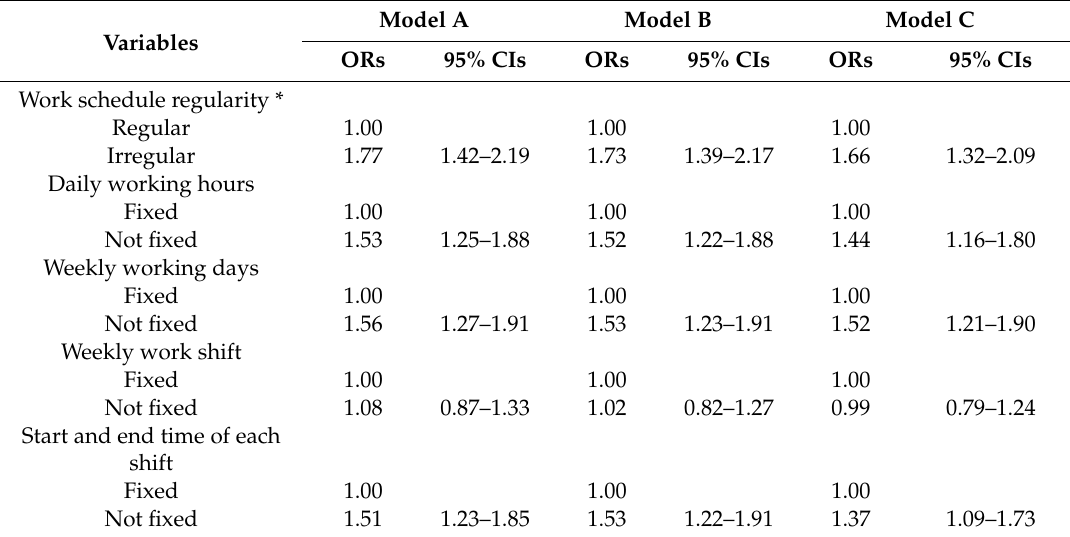
Table 2. Odds ratio and 95% confidence intervals for work-related injury in models A, B, and C. Model